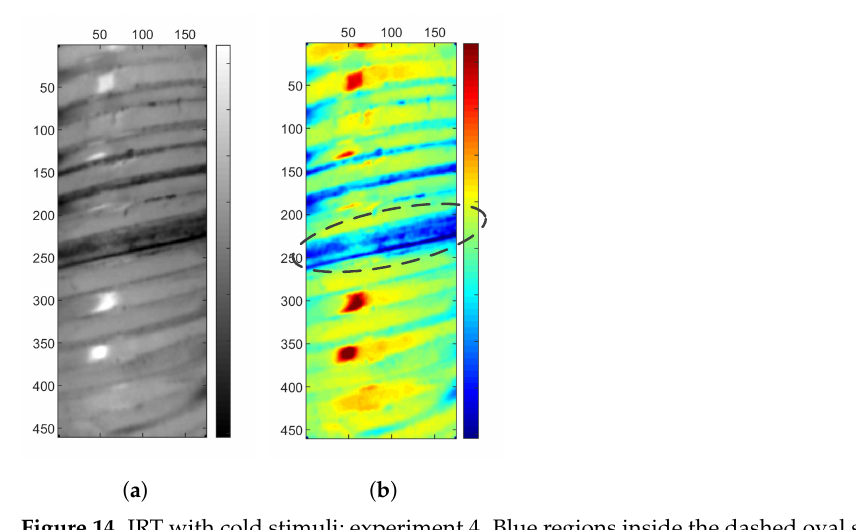
Figure 14. IRT with cold stimuli; experiment 4. Blue regions inside the dashed oval show the effect of a cold stimulus behind the specimen. ( a ) The processed image. ( b ) Color